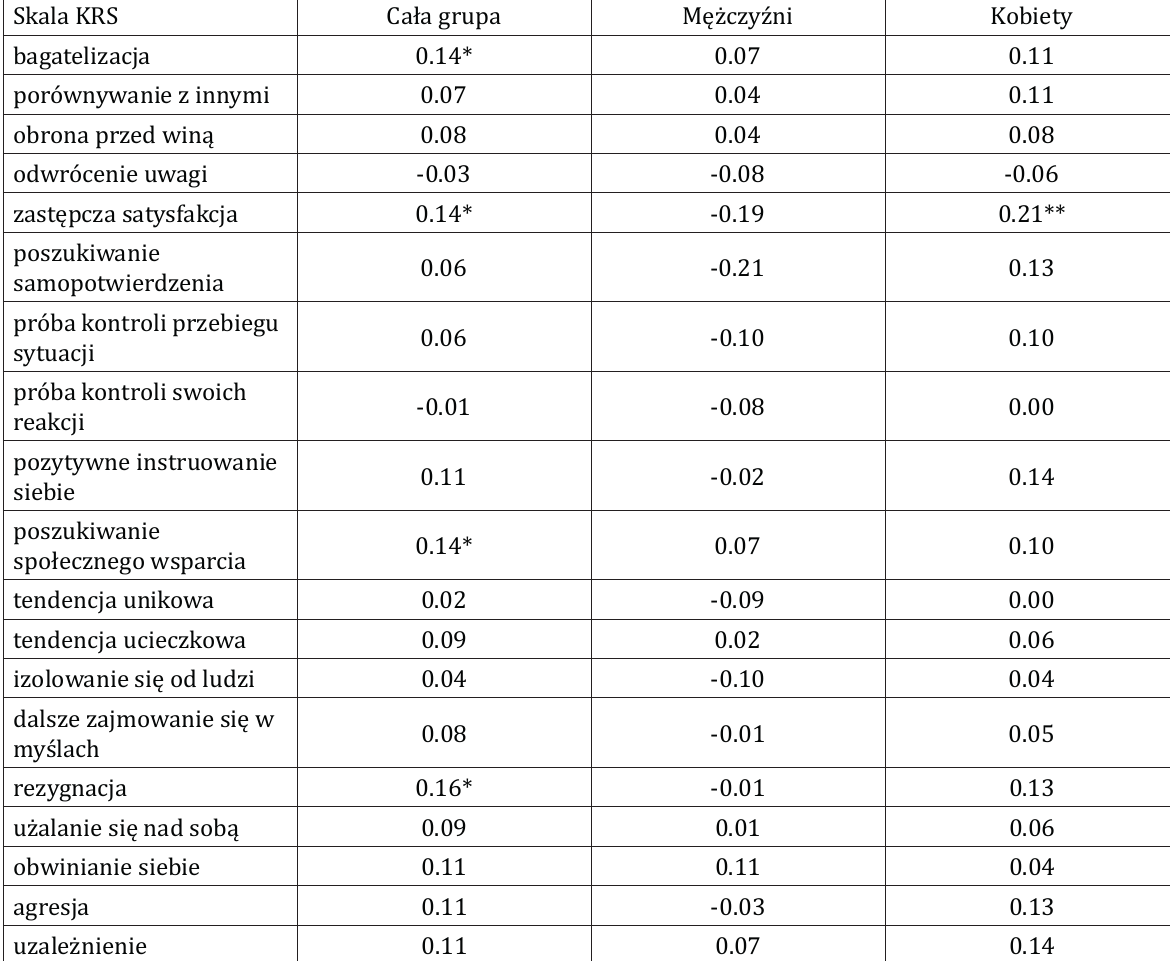
Tabela 3. Współczynniki korelacji między długością czasu spędzanego na portalu społecznościowym a skalami Kwestionariusza